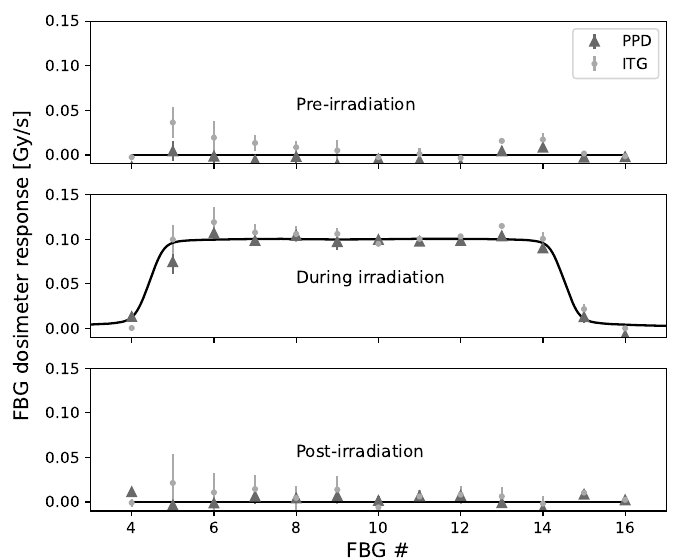
Figure 8. Mean slope and standard deviation over three different irradiations for every FBG in the multi-points dosimeter. The 51 s pre-irradiation, 200 s during irradiation, and the 60 s post-irradiation are presented for both the PPD technique and the ITG technique. The continuous line represents the expected values, which were measured with an ion